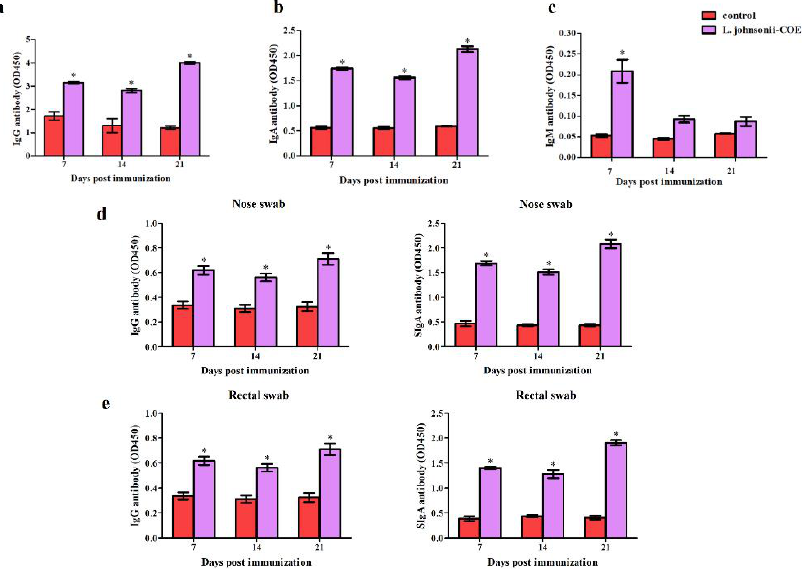
Figure 6. The IgG, IgA, SIgA, and IgM antibody levels of the immunized sow. ( a – c ) Serum anti-PEDV IgG ( a ), IgA ( b ), IgM ( c ) antibody levels; ( d ) nasal mucosa anti-PEDV IgG and SIgA antibody levels; ( e ) rectal mucosa anti-PEDV IgG and SIgA antibody levels. * ( p < 0.05).